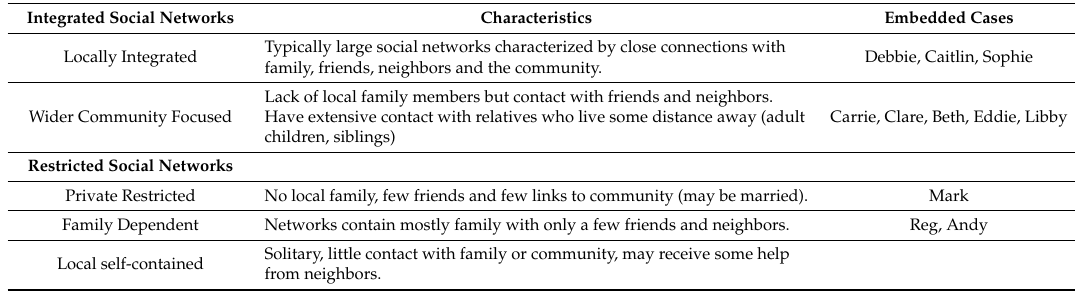
Table 2. Network Typologies.